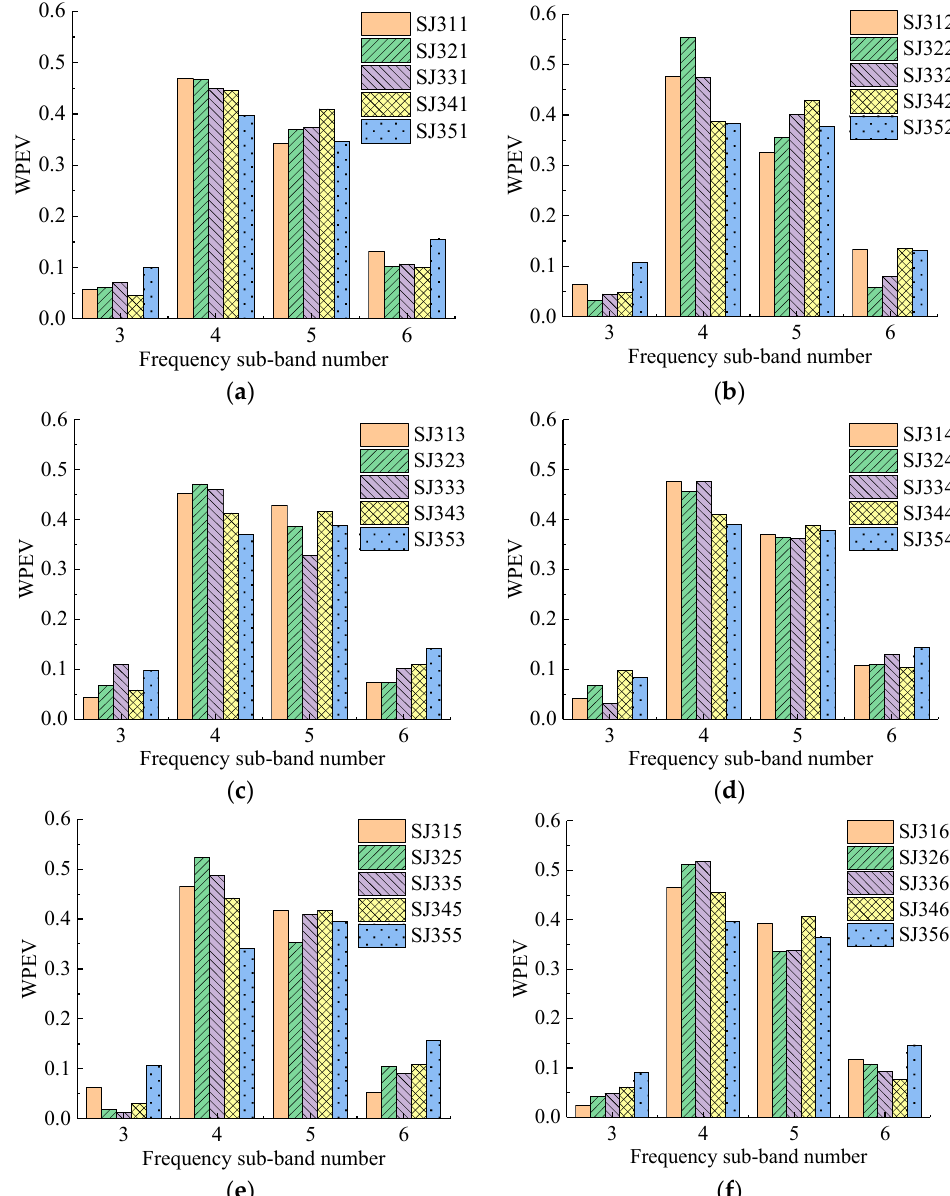
Figure 8. The WPEVs of different detecting points of the SJ3 group. ( a ) Detecting point 1, ( b ) Detecting point 2, ( c ) Detecting point 3, ( d ) Detecting point 4, ( e ) Detecting point 5, ( f ) Detecting point 6.